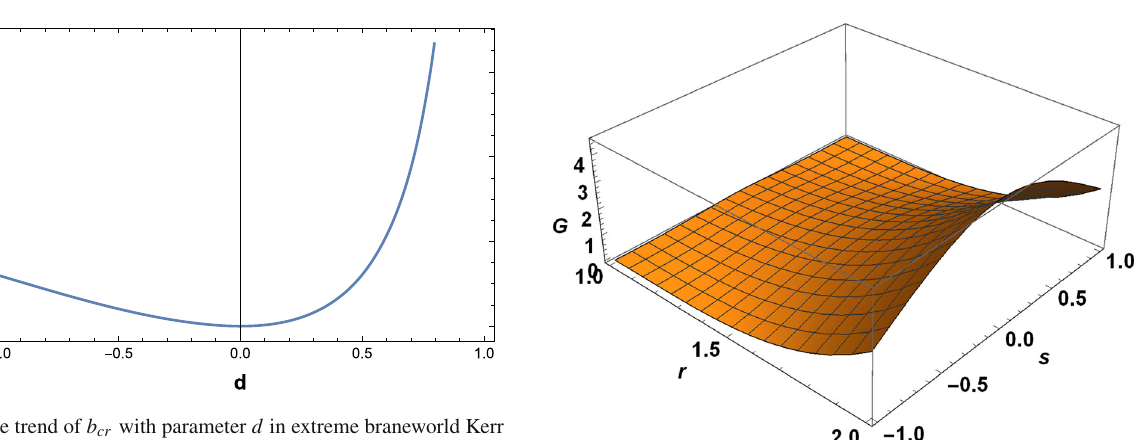
Fig. 1 The trend of b cr with parameter d in extreme braneworld Kerr black hole